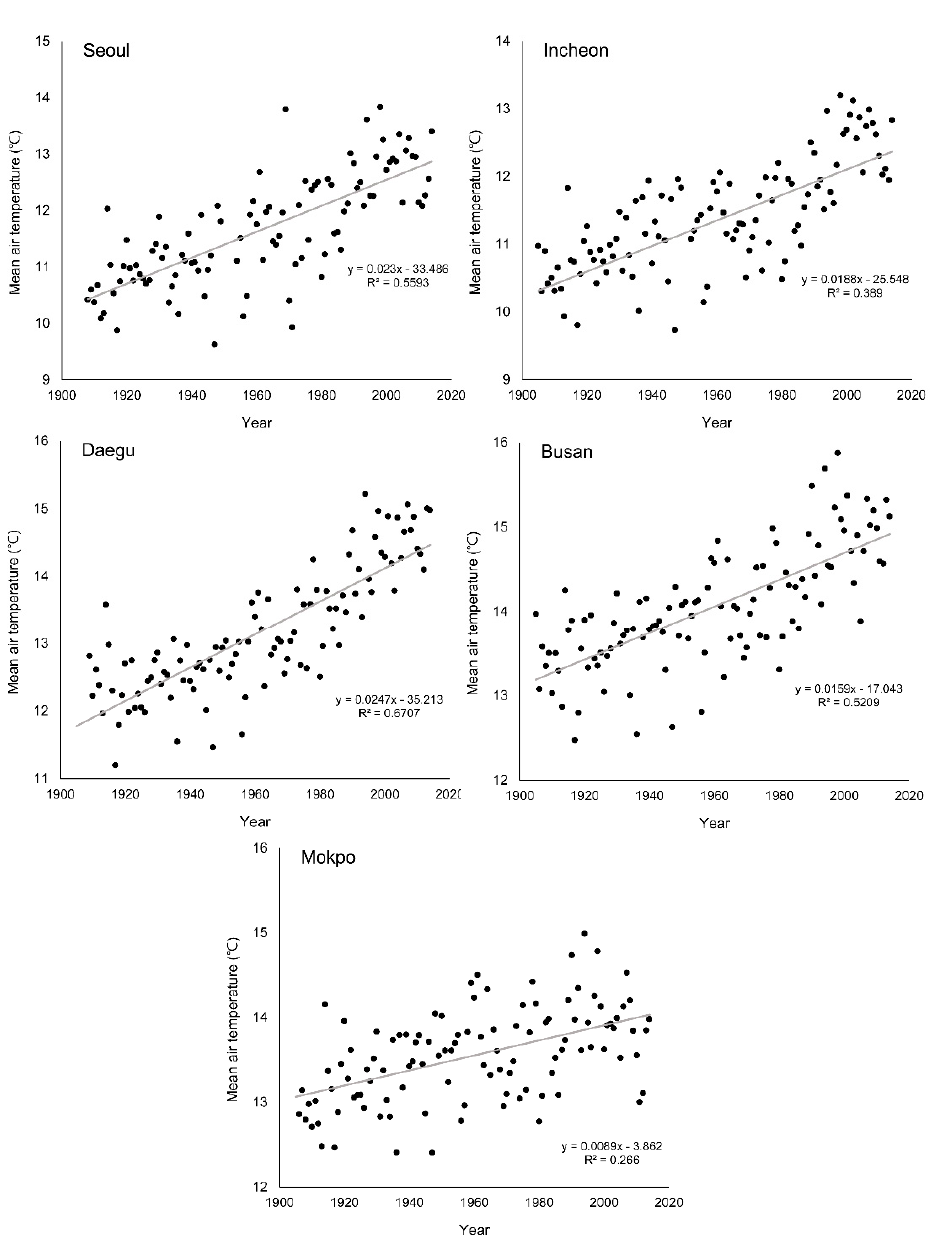
Figure 9. Changes of the annual mean air temperature during the past century in major cities of South Korea.